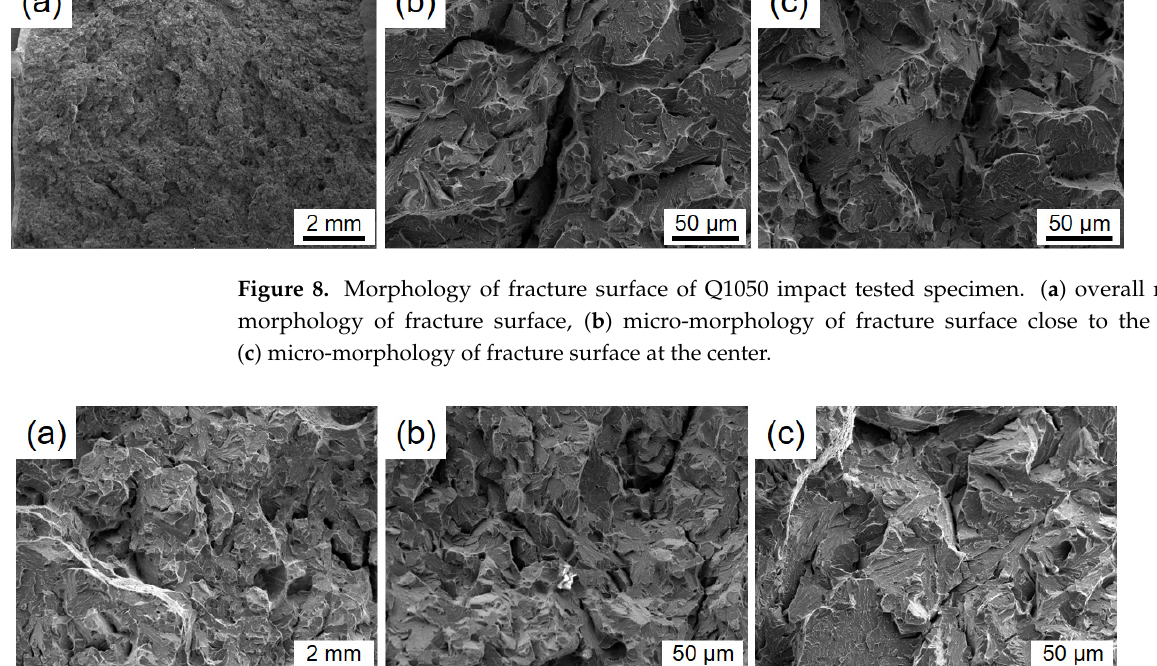
Figure 7. Morphology of fracture surface of Q950 impact tested specimen. ( a ) overall macro-morphology of fracture sur- face, ( b ) micro-morphology of fracture surface close to the notch, ( c ) micro-morphology of fracture surface at the center.